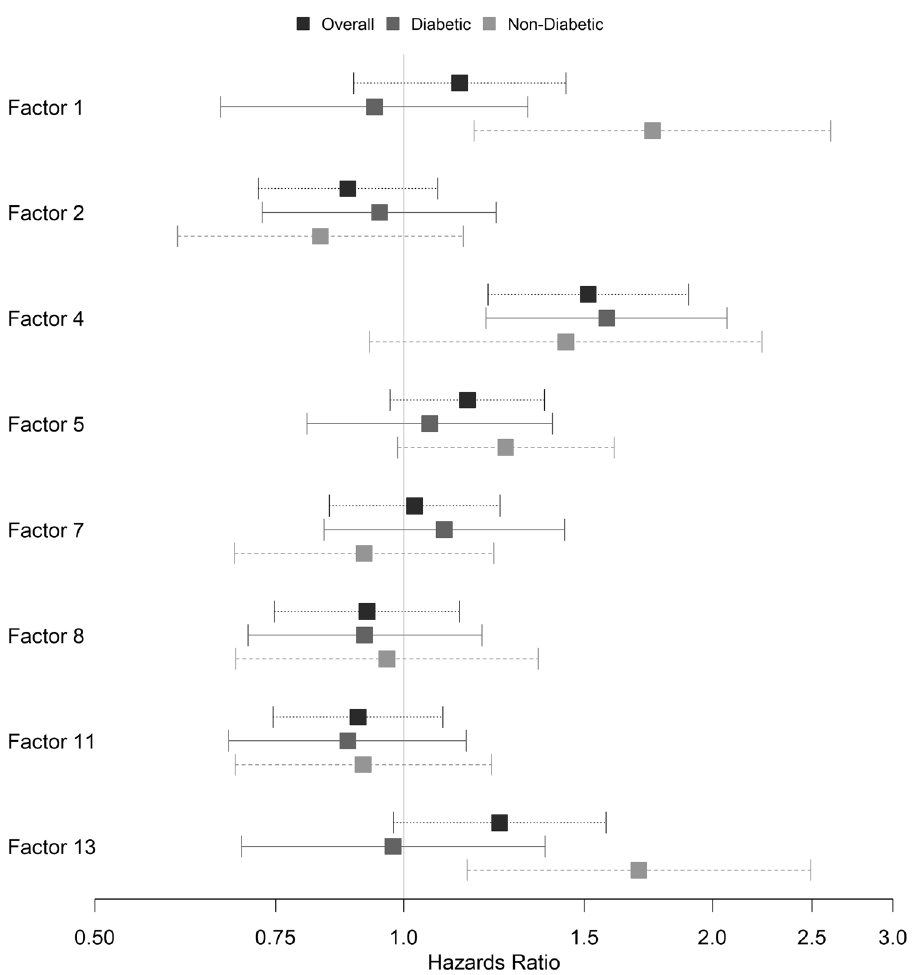
Figure 2. Forest plot of hazards ratios for baseline metabolite factor associations with time-to-event (death or heart failure hospitalization). Shown are hazards ratios for the overall cohort and those individuals with and without T2DM.